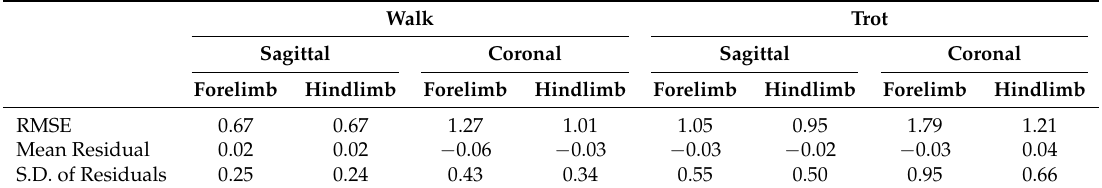
Table 2. Summary of difference statistics for the limb angle signals (values in degrees). RMSE: root-mean-square error; S.D: standard deviation.